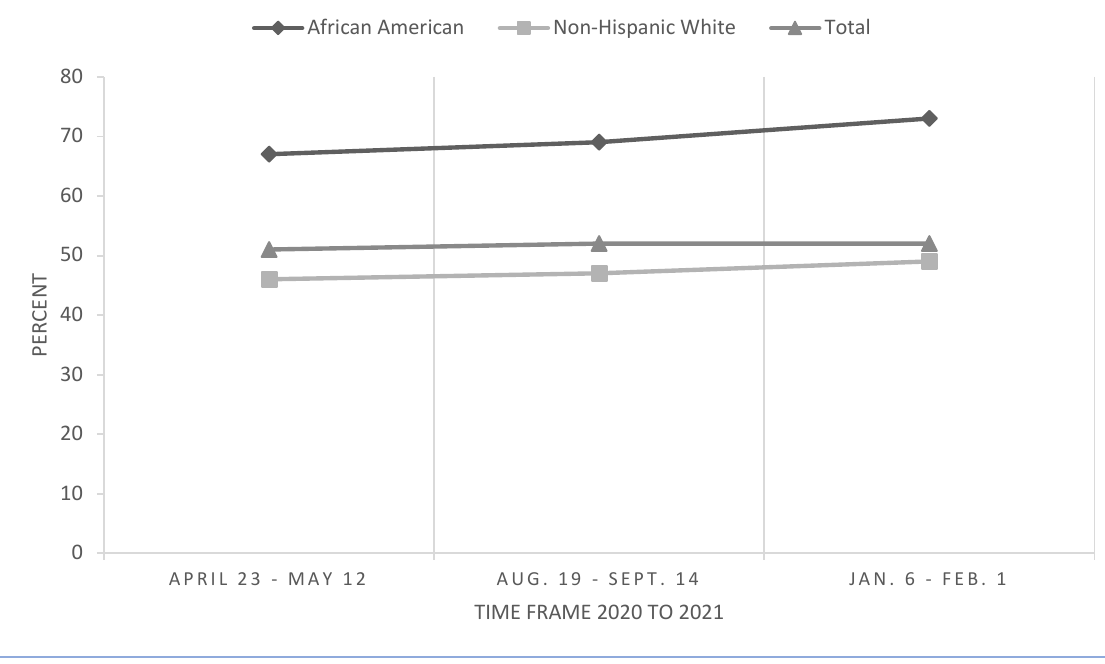
Family Households